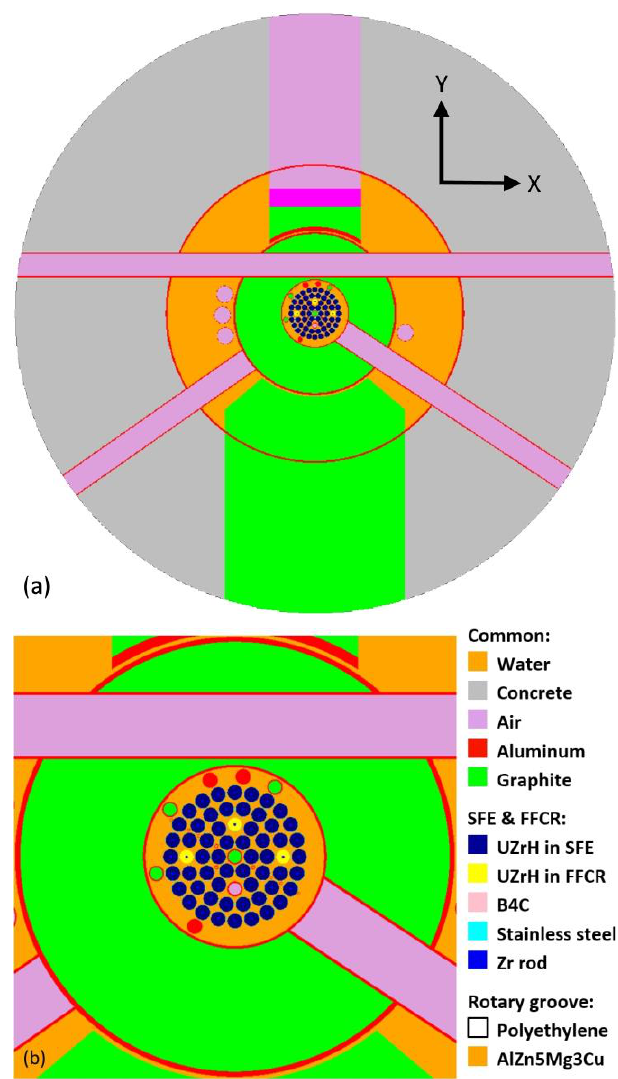
Fig. 4. Z = -8 cm XY top-view of FC5 TRIPOLI-4 JSI TRIGA model (a) with zoom on the core